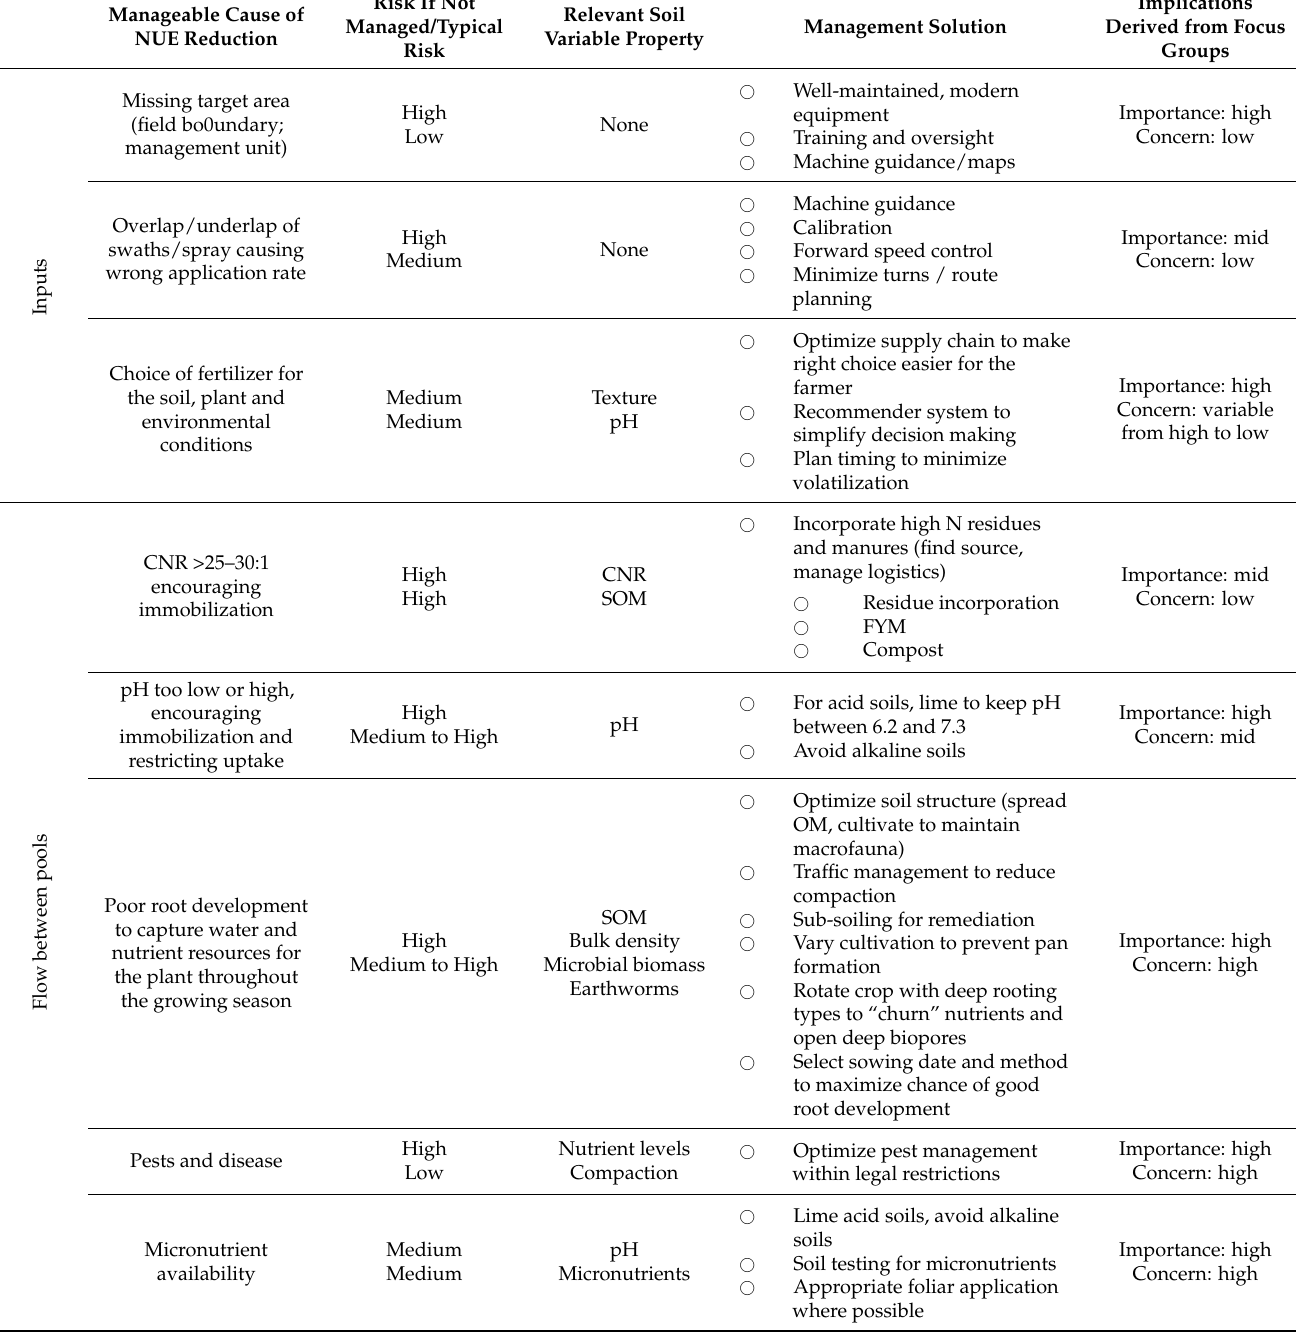
Table 2. Manageable causes of nitrogen use efficiency (NUE) reduction, the associated risk, and management